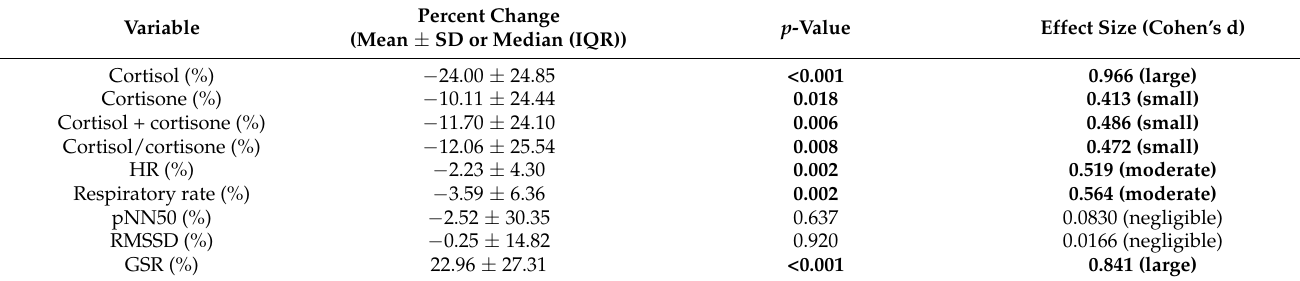
Table 5. Percent change in biochemical and physiological stress